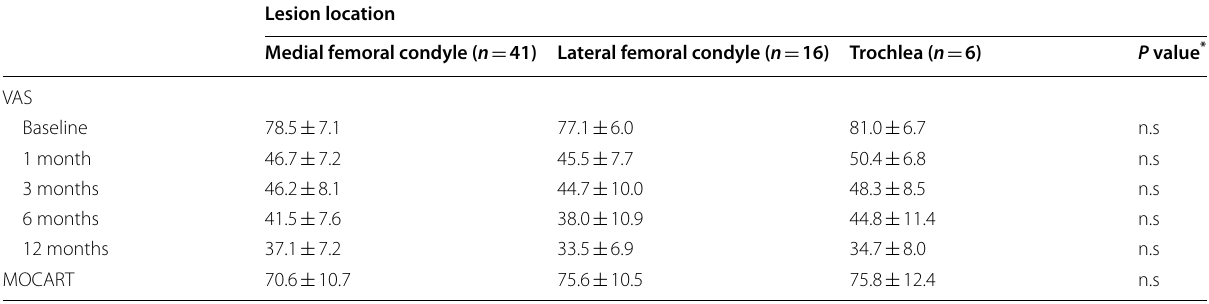
Data are presented as means standard deviation ± MOCART Magnetic resonance observation of cartilage repair tissue, VAS Visual analogue scale * Kruskal–Wallis